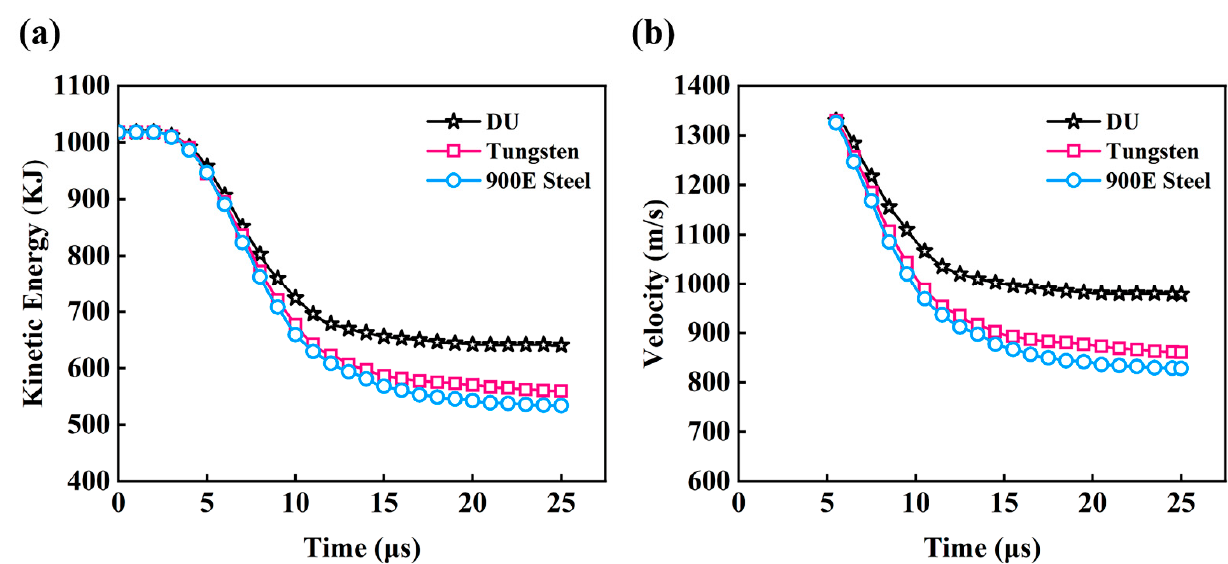
Figure 3. Variation of kinetic energy and velocity of different alloy bullets with penetration time ( a ) kinetic energy–time; ( b ) velocity–time.